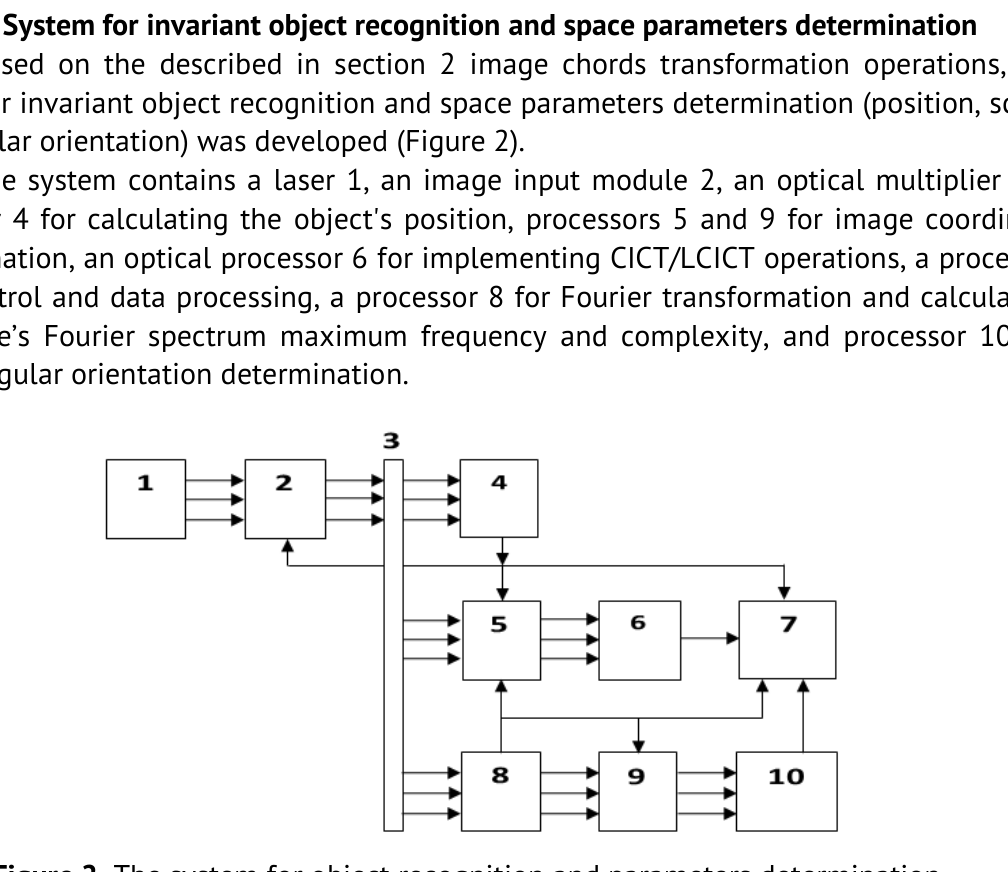
Figure 2. The system for object recognition and parameters